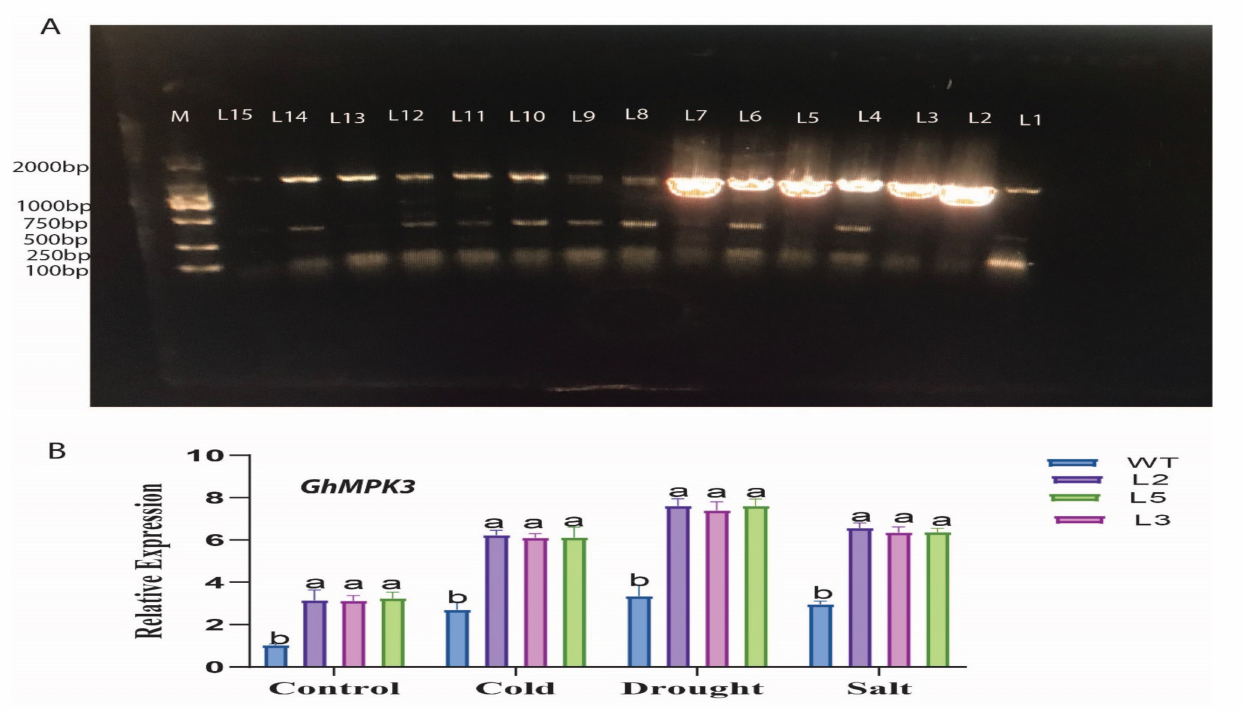
Figure 3. Gene expression analysis of GhMPK3 ( Gh_D05G3876 ). ( A ). PCR analysis result to check the 1200-bp CDS integration in transformed Arabidopsis plants, L 1–L14: GhMPK3 -overexpressed lines, L15: WT. ( B ). GhMPK3 gene expression level under abiotic stress (cold, drought, and salt) in transformed Arabidopsis and WT by qRT-PCR. Each experiment was performed three times. The bar represents a standard error (SE). Various letters above the columns indicate statistically significant differences (ANOVA, p < 0.05). WT: Wild type. L2, L3, L5: Overexpressed